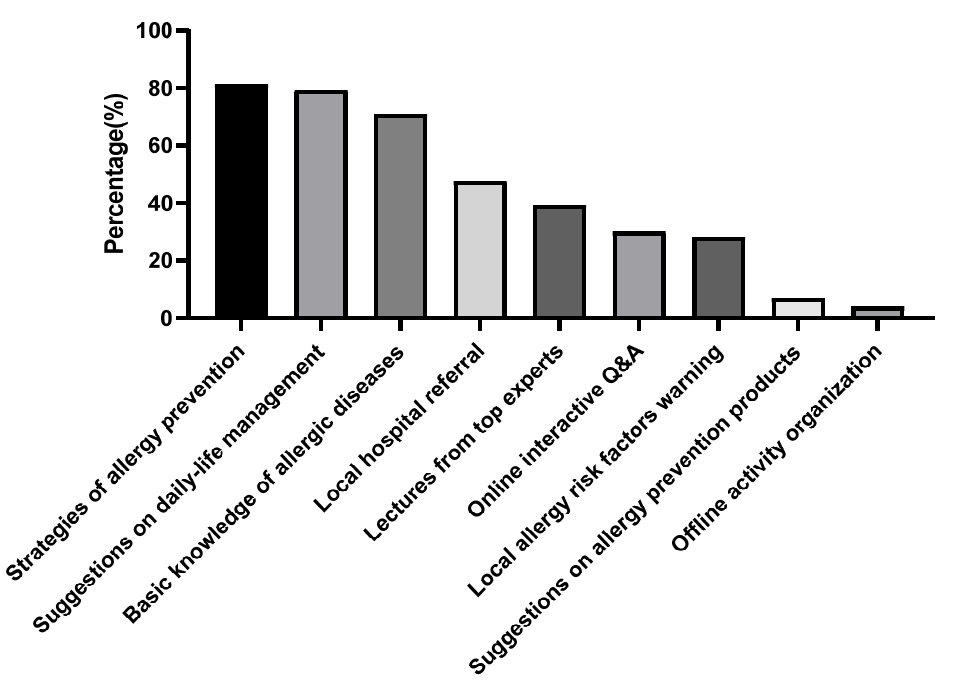
Figure 2. The online platform improvements the patients needed for obtaining professional informa- tion and recommendations. ( n = 315). Table 1. Descriptive characteristics of the patients with respiratory allergies ( n = 576).